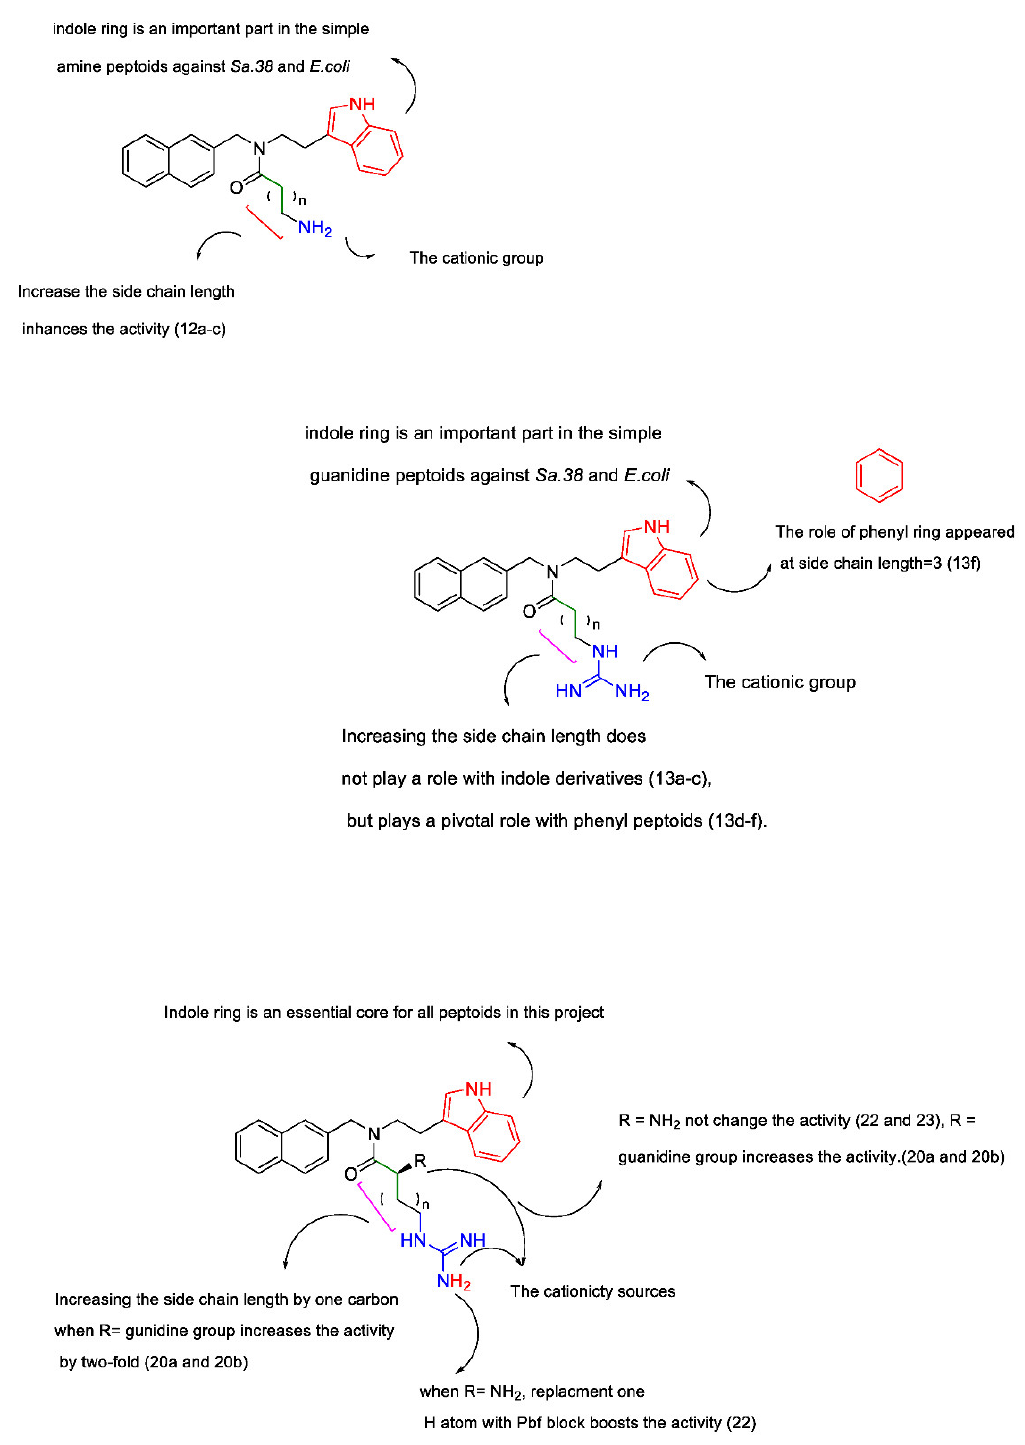
Figure 8. Antibacterial SAR of compounds that showed potent and good activity against S. aureus